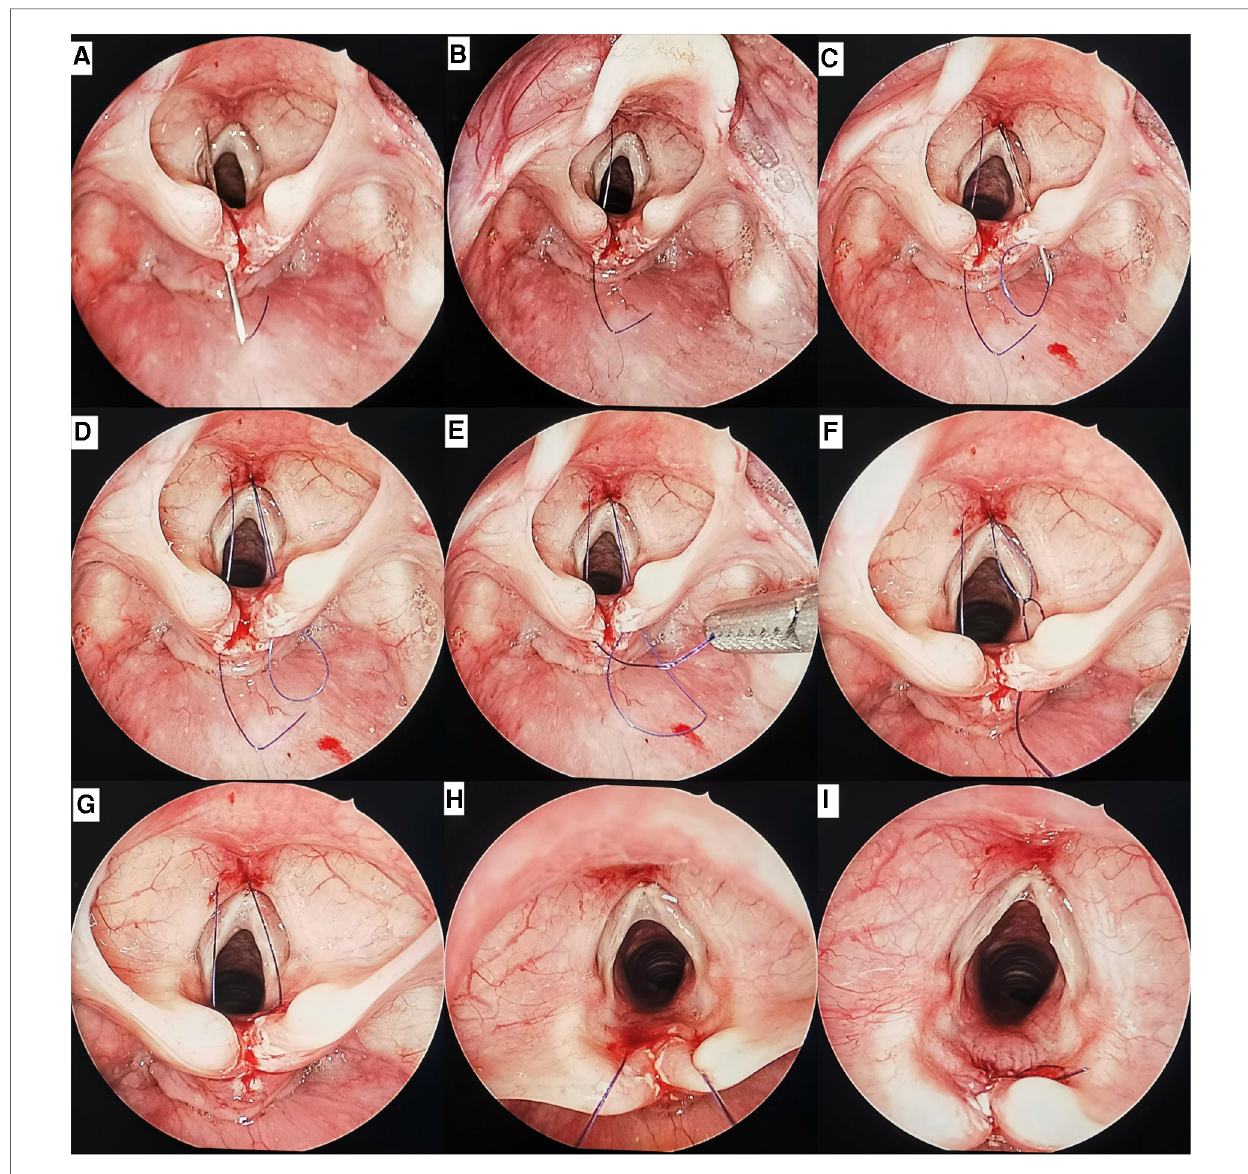
FIGURE 3 Endoscopic views of a type 1 cleft by endoscopic percutaneous repair: ( A ) the 22-gauge needle with suture #1 inserted into the airway percutaneously, then penetrated the mucosal at the left edge of the cleft and entered the esophagus. ( B ) The end of suture #1 was pulled into the esophagus, the 22- gauge needle was withdrawn. ( C ) The 22-gauge needle with suture #2 inserted into the airway percutaneously, then penetrated the mucosal at the right edge of the cleft and entered the esophagus. ( D ) The loop of suture #2 was pulled into the esophagus, the 22-gauge needle was withdrawn. ( E ) The end of suture #1 was passed though the loop of suture #2. ( F ) The end of suture #1 was pulled into the airway by the loop of suture #2. ( G ) Both ends of suture #1 were located in the airway. ( H ) The both ends of suture #1 was pulled out of the barrel. ( I ) The knot was tied on the side of the